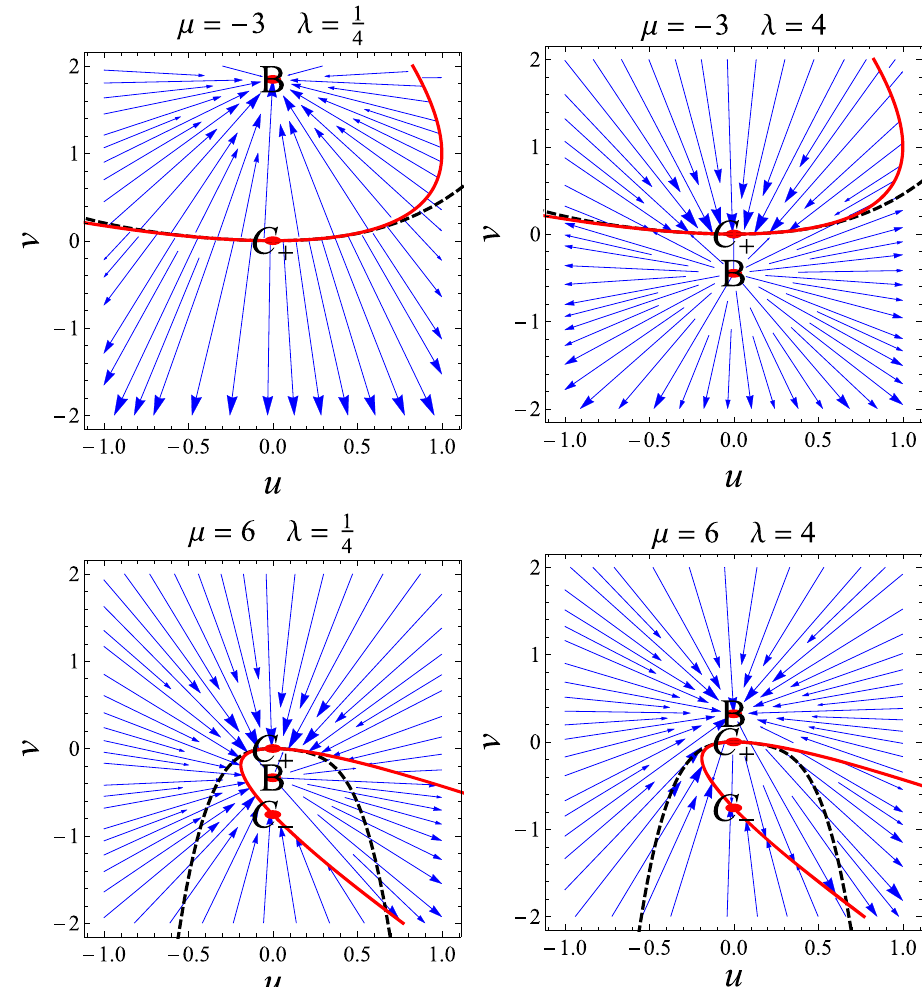
Fig. 4 Qualitative evolution in the phase plane ( u ,v) given by (38) for ω = 0. The solid red lines denote the implicit (cid:9) (cid:10) √ + x ( u )ω + function x ( u ) 6 y ( u ,v) 2 + 1 = 0, with x ( u ) and y ( u ,v) defined by (37) for ω = 0, whereas the dashed black lines represent the approximated center manifold of C + .